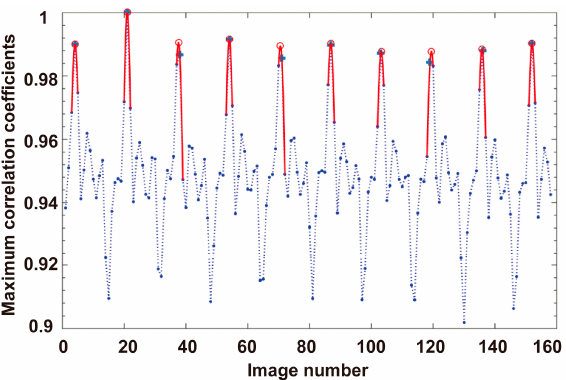
Figure 10. Maximum correlation coefficients between each frame of the video and the reference frame. The blue symbol “+” in shows the peak points of the maximum correlation coefficient sequence. The red symbol “o” denotes the maximum points of the calculated parabolic curves.